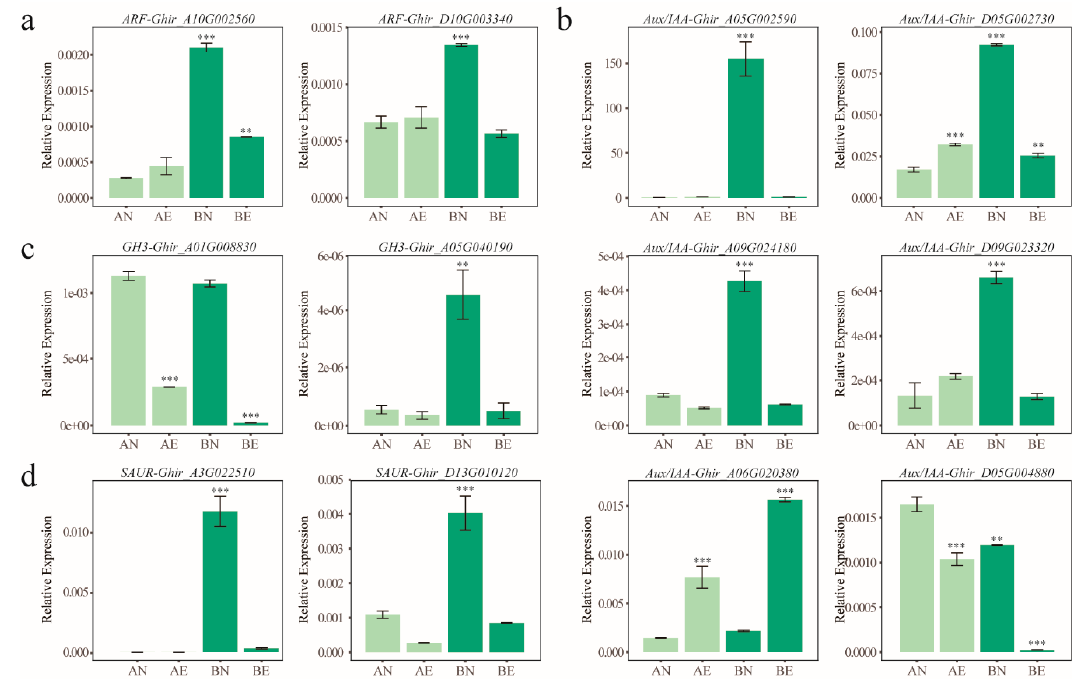
Figure 5. qRT-PCR analysis showing the expression of auxin early response ARF ( a ), Aux/IAA ( b ), GH3 ( c ), and SAUR ( d ) genes during transformation from NEC to EC. Callus samples from CCRI12 and CCRI24 were colored in light green and dark green, respectively. Multiple comparisons of expression levels between di ff erent samples were conducted with AN chosen as the reference. Statistically significant di ff erences are displayed with asterisks (‘***’ p -value ≤ 0.001, ‘**’ p -value ≤